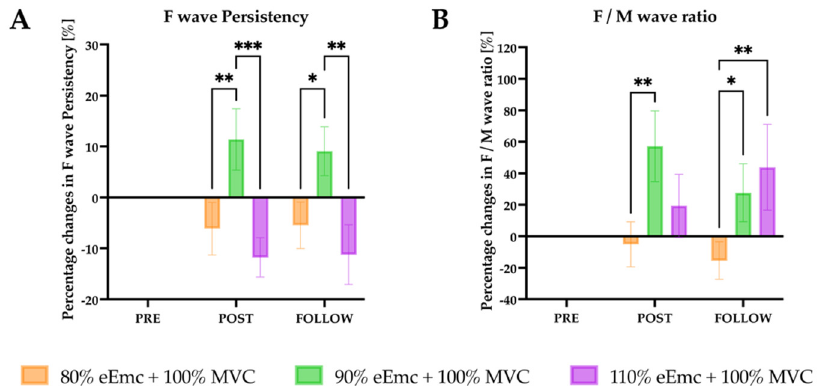
Figure 3. F wave persistency and F/M wave ratio. ( A ) percentage changes in F wave persistency with respect to baseline. Intervention simple effect showed significant differences of 90% eEmc with respect to 80% ( ** p = 0.0079) and 110% eEmc ( *** p = 0.0005) at post and at follow ( * p = 0.0304; ** p = 0.0020); ( B ) percentage changes in F/M ratio with respect to baseline. Intervention simple effect showed significant differences at post of 90% and 80% eEmc ( ** p = 0.0032); and at follow of 80% eEmc and 90% ( * p = 0.0491) and 110% eEmc ( ** p = 0.0051).